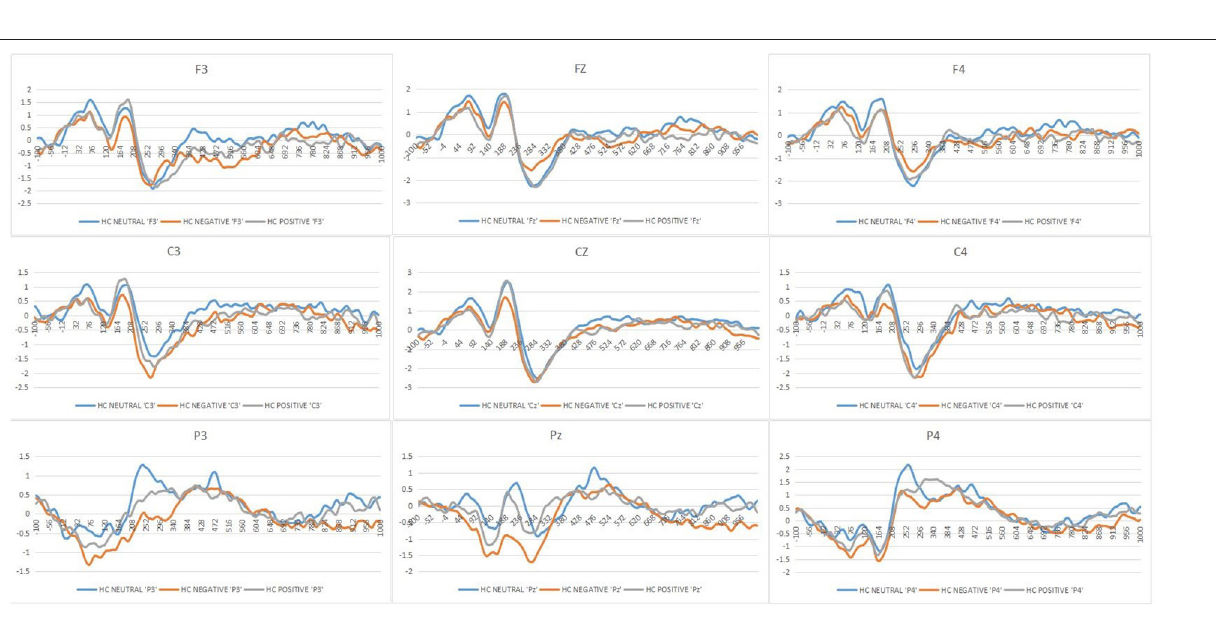
1,000 HZ during acquisition, then was resampled at